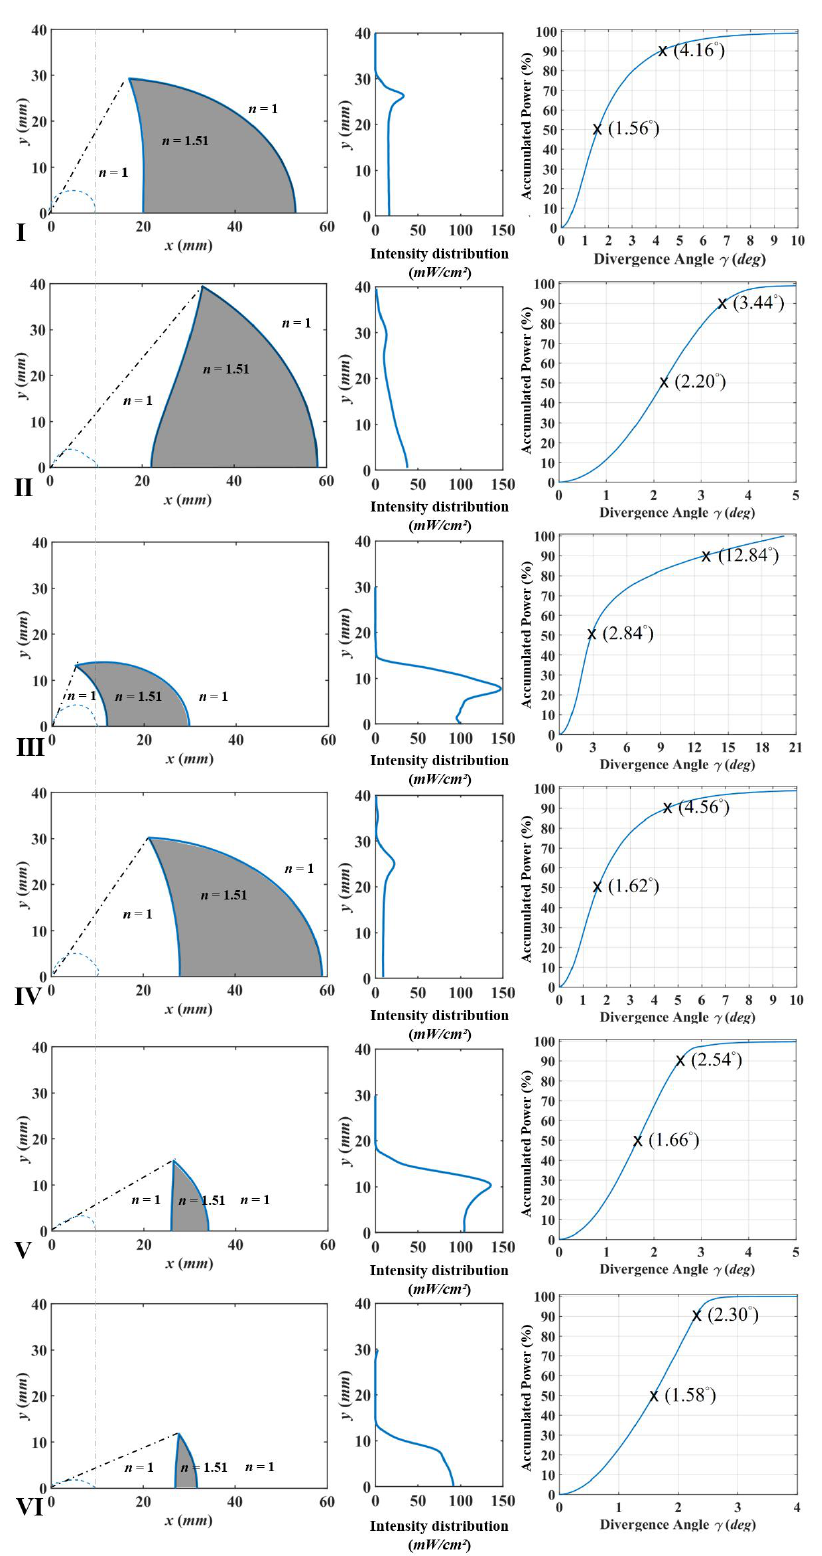
Figure 5. (from left to right) The collimating lens profiles, illuminance distribution on the detector plane, and statistics of accumulated power as a function of divergence angle for each of the six ( I – VI ) UV-LED light